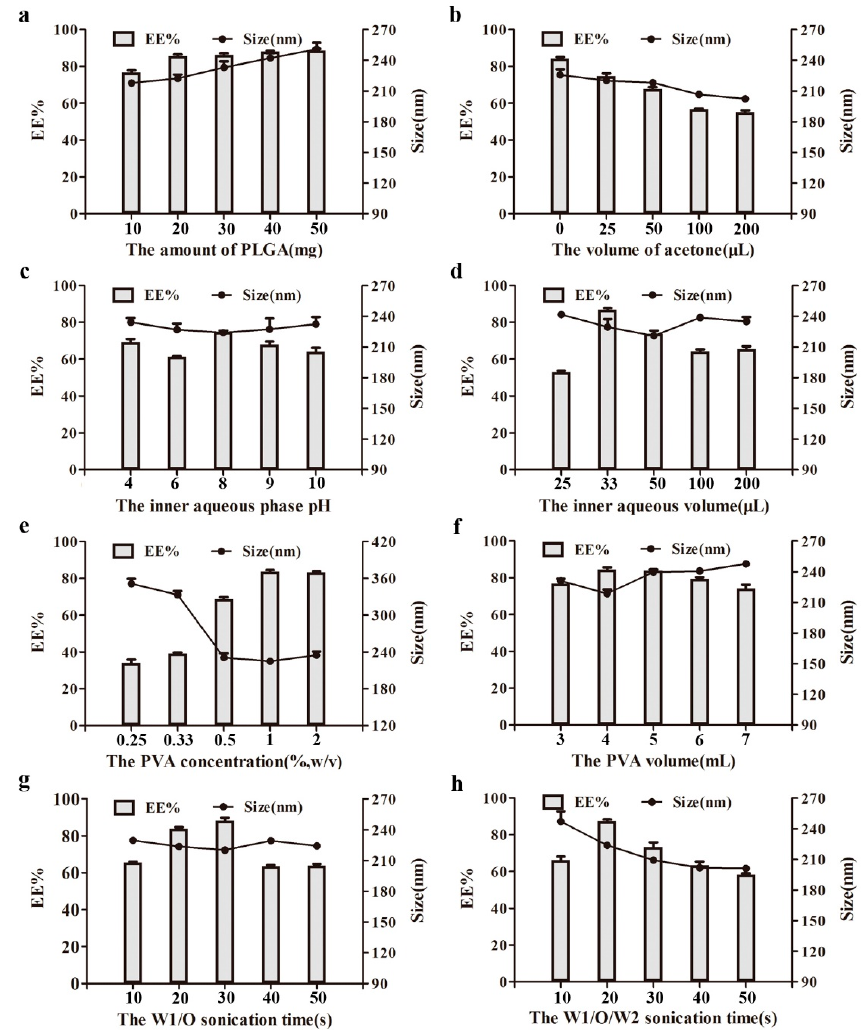
Figure 1. Effect of various processing parameters on the particle size (nm) and entrapment efficiencies (EE%) of nanoparticles, including the amount of poly-(lactic- co -glycolic) acid (PLGA) ( a ), the volume of acetone ( b ), the pH ( c ) and volume ( d ) of inner aqueous phase, the concentration ( e ) and volume ( f ) of poly (vinyl alcohol) (PVA), and the sonication time of W1/O ( g ) and W1/O/W2 ( h ). ( n = 3).